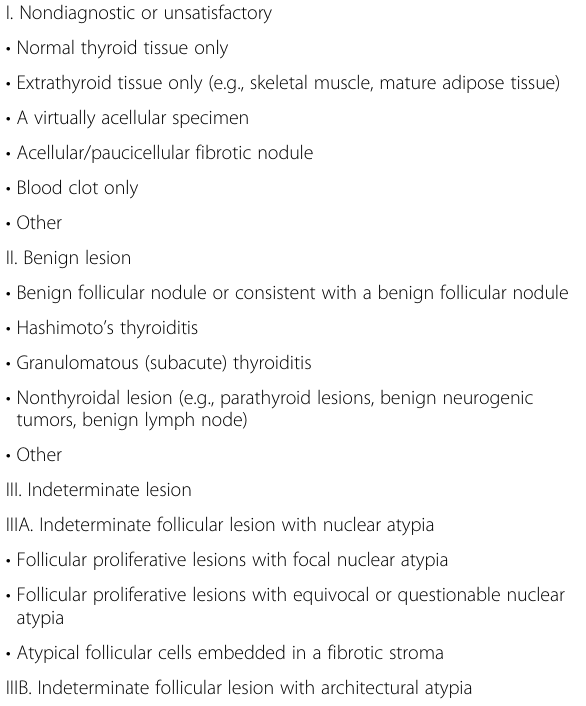
Table 1 Diagnostic Categories of Thyroid Core Needle Biopsy Proposed by The Korean Endocrine Pathology Thyroid Core Needle Biopsy Study